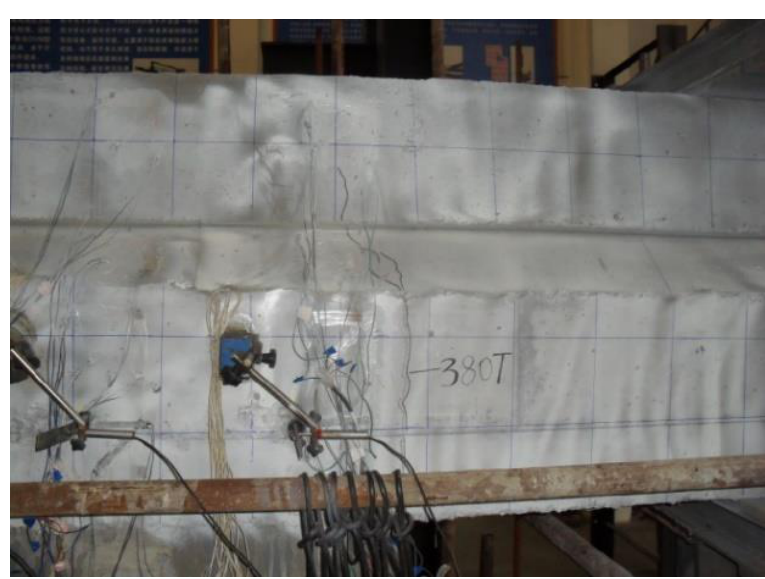
Figure 10. The concrete crack in CJB.